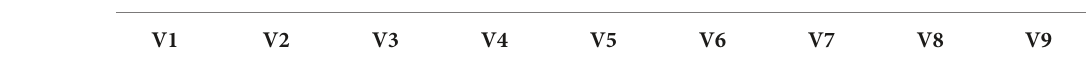
TABLE 4 Effect of different concentrations of NaCl on uptake of Na + of different barley genotypes. Parameters Na + Level